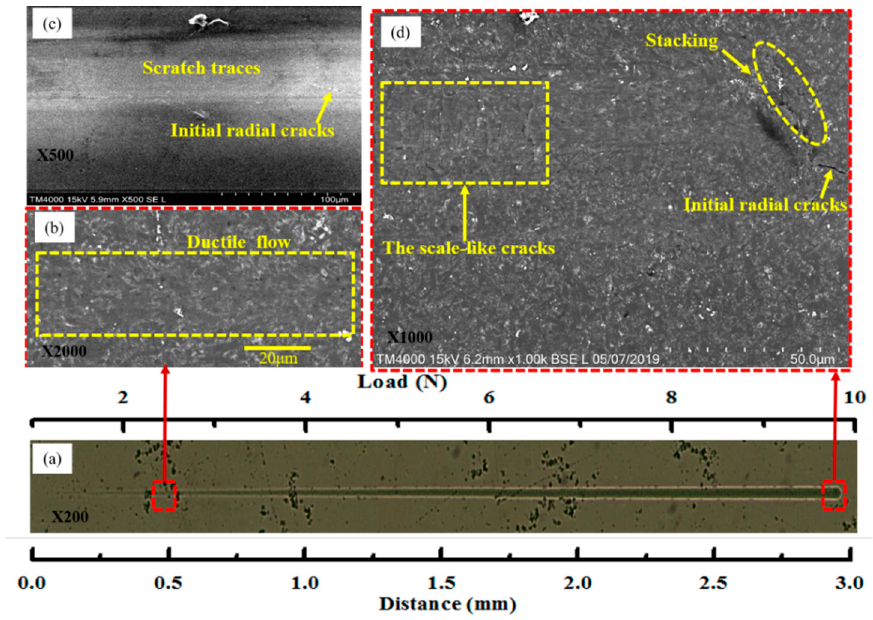
Figure 7. Surface morphology of silicon nitride after scratching (SEM) at a 1–10 N loading: ( a ) full view; ( b ) ductile removal stage; ( c ) brittle removal stage; ( d ) morphology of brittle removal stage.